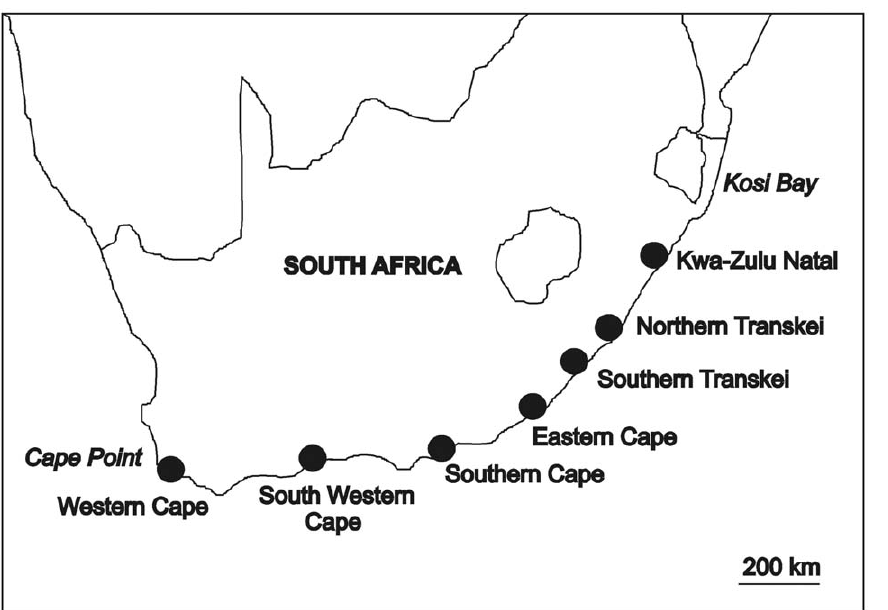
Figure 1. Map of South Africa showing the 7 different regions which were sampled within the geographic range of Siphonaria concinna and S.serrata . For both species, Cape Point is the western limit and Kosi Bay is the eastern limit.